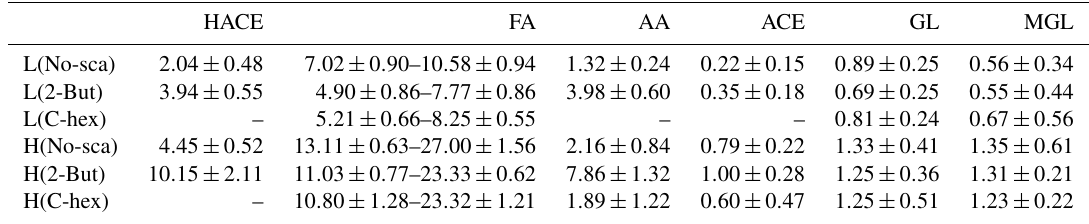
Table 4. Yields (%) of carbonyls at a low or high [O 3 ] / [limonene] ratio in the presence or absence of the OH scavenger. HACE